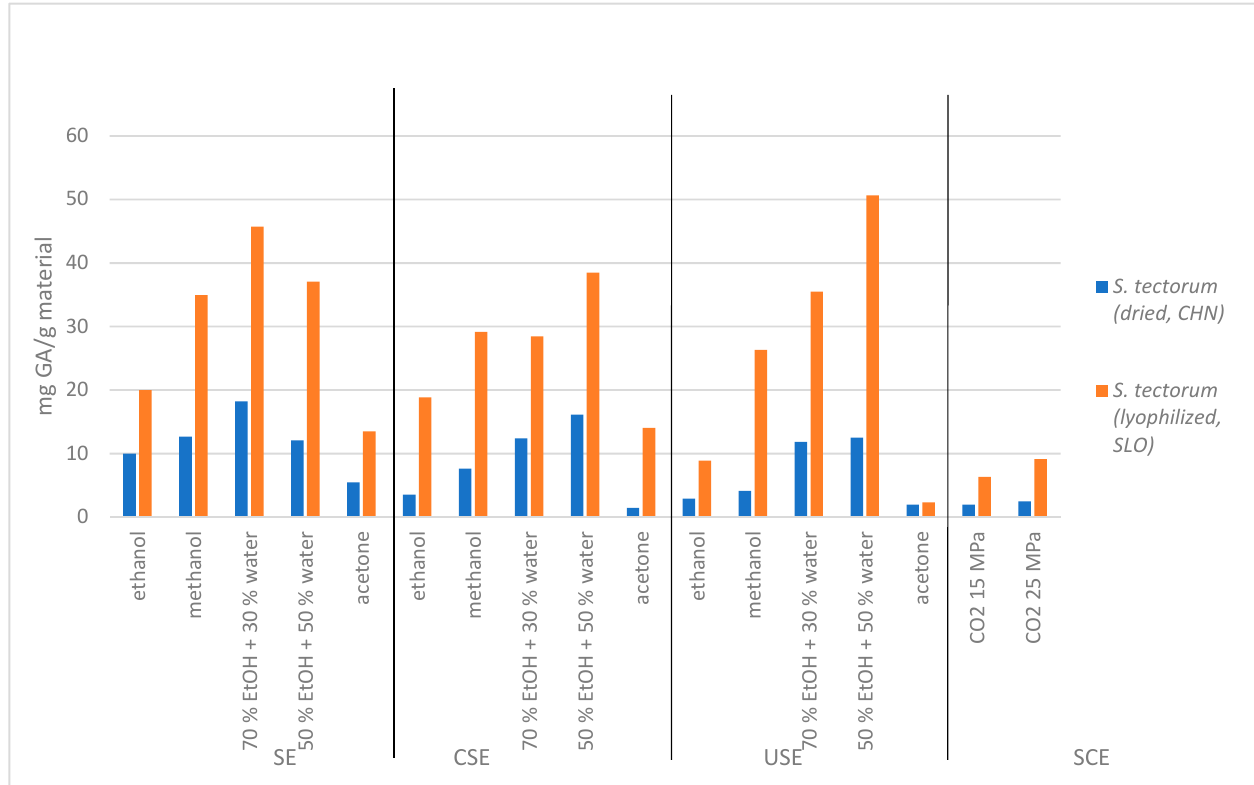
Figure 1. Total phenolic content in S. tectorum extracts (SE, Soxhlet extraction; CSE, cold solvent extraction; USE, ultrasound extraction; SCE, supercritical extraction).